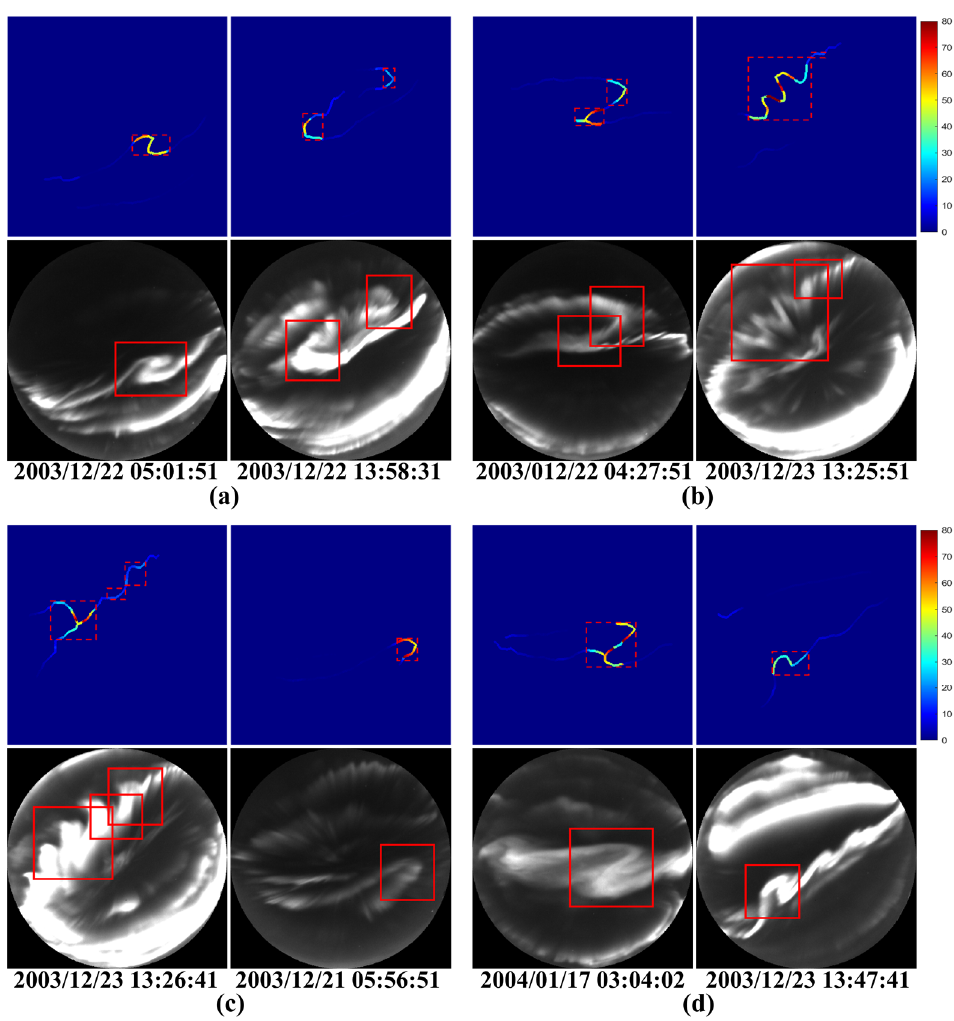
Figure 7. Identification results of different types of folds, including ( a ) one and more fold structures, ( b ) large-scale and small-scale fold structures, ( c ) weak and strong auroral emission, and ( d ) diffusion and discrete structures.